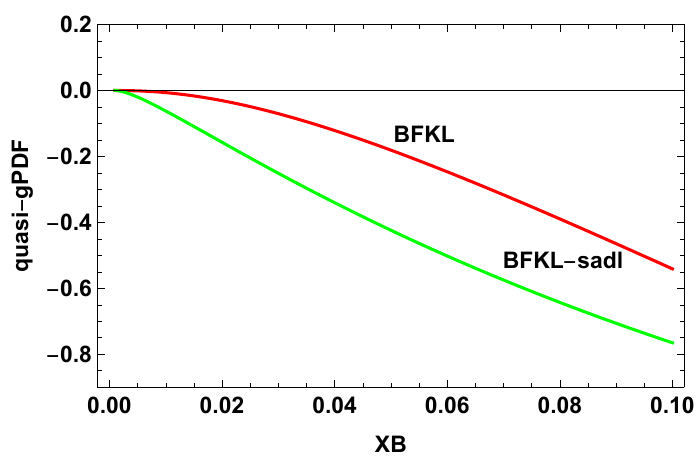
Figure 10 . Here we compare eq. (8.3) (real part) with its saddle point approximation, (8.4) (real part). The curves are plotted in the range x B ∈ [0 . 001 , 0 . 1] with P ξ = 4